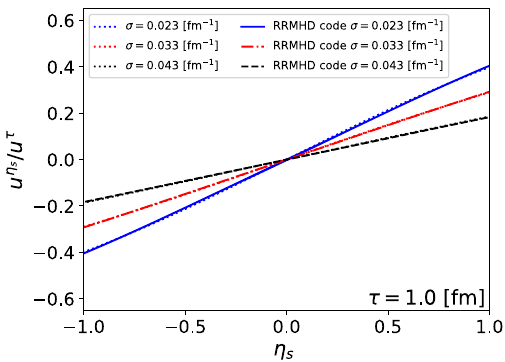
Fig. 18 The electrical conductivity dependence of the fluid velocity component v η at τ = 1 . 0 fm. The blue solid, red long dashed-dotted and black dashed lines show the numerical results in the cases of σ = 0 . 023 , 0 . 033 and 0 . 043 fm − 1 fm, respectively. The blue, red, and black dotted lines show the semi-analytic solutions given by Eqs. (80) and (81) in the cases of σ = 0 . 023 , 0 . 033 and 0 . 043 fm − 1 , respectively